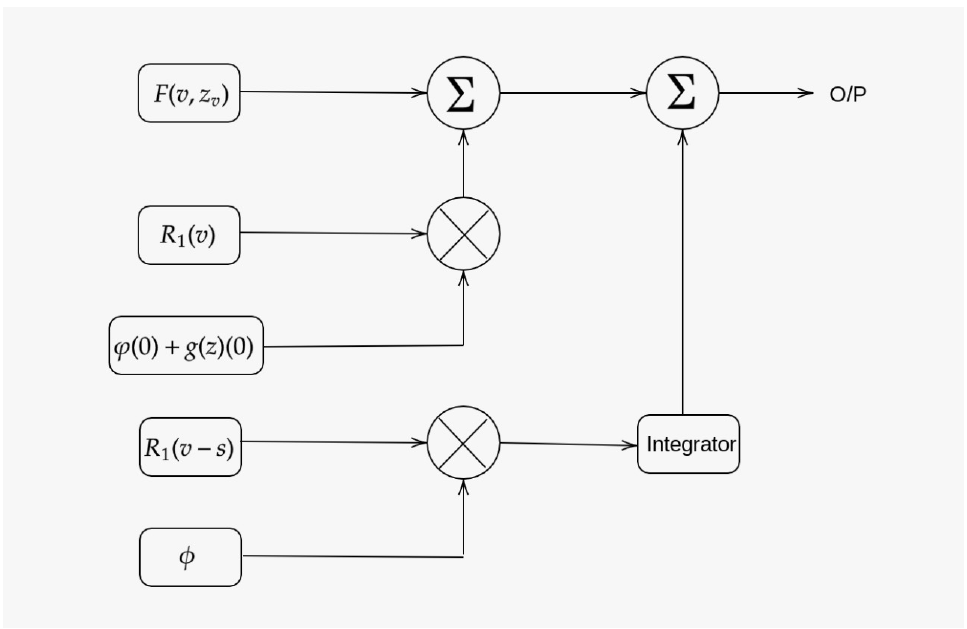
Figure 1. Filter